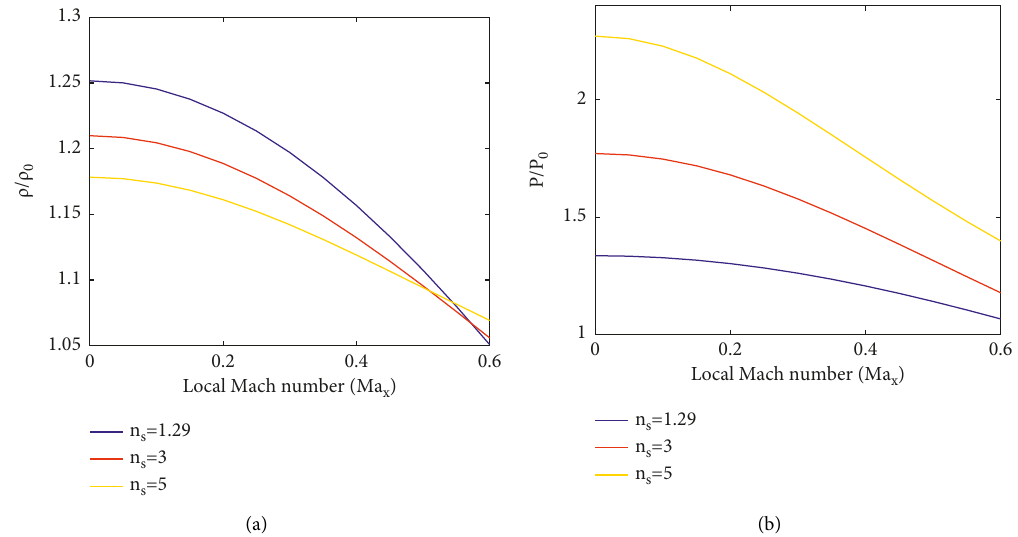
Figure 4: Isentropic exponent effects at the impeller outlet. (a) Density and (b)